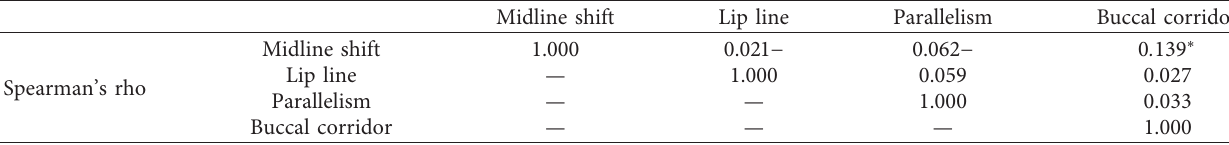
Table 3: Correlation matrix for the association between smile